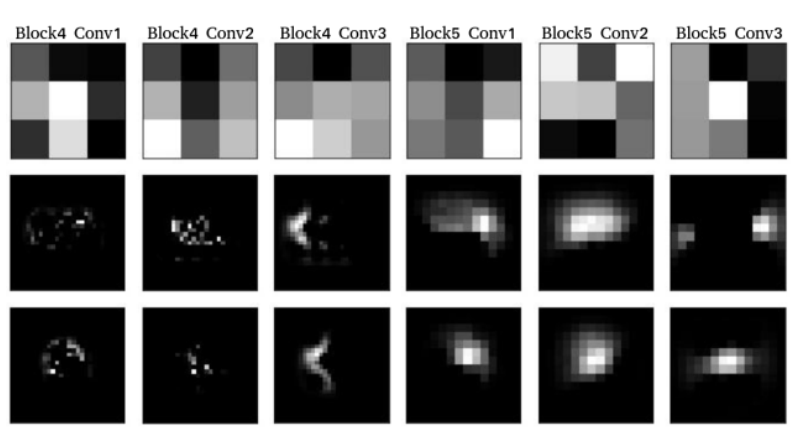
Figure A4. Kernels of VGG16 and the respective activations of the AFM images of anthracene and benzene molecules. From left to right the activations represent features from lowest to highest level. The activations show the matches of the kernels with the input image of the respective layer, which is the information that “passes through” that filter to the next layer. The filters are not more complex in deeper layers, reflecting that the features are of a higher level when the image has been processed by more